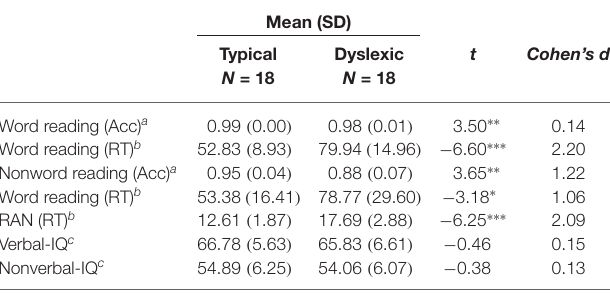
TABLE 1 | Reading scores on cognitive and literacy